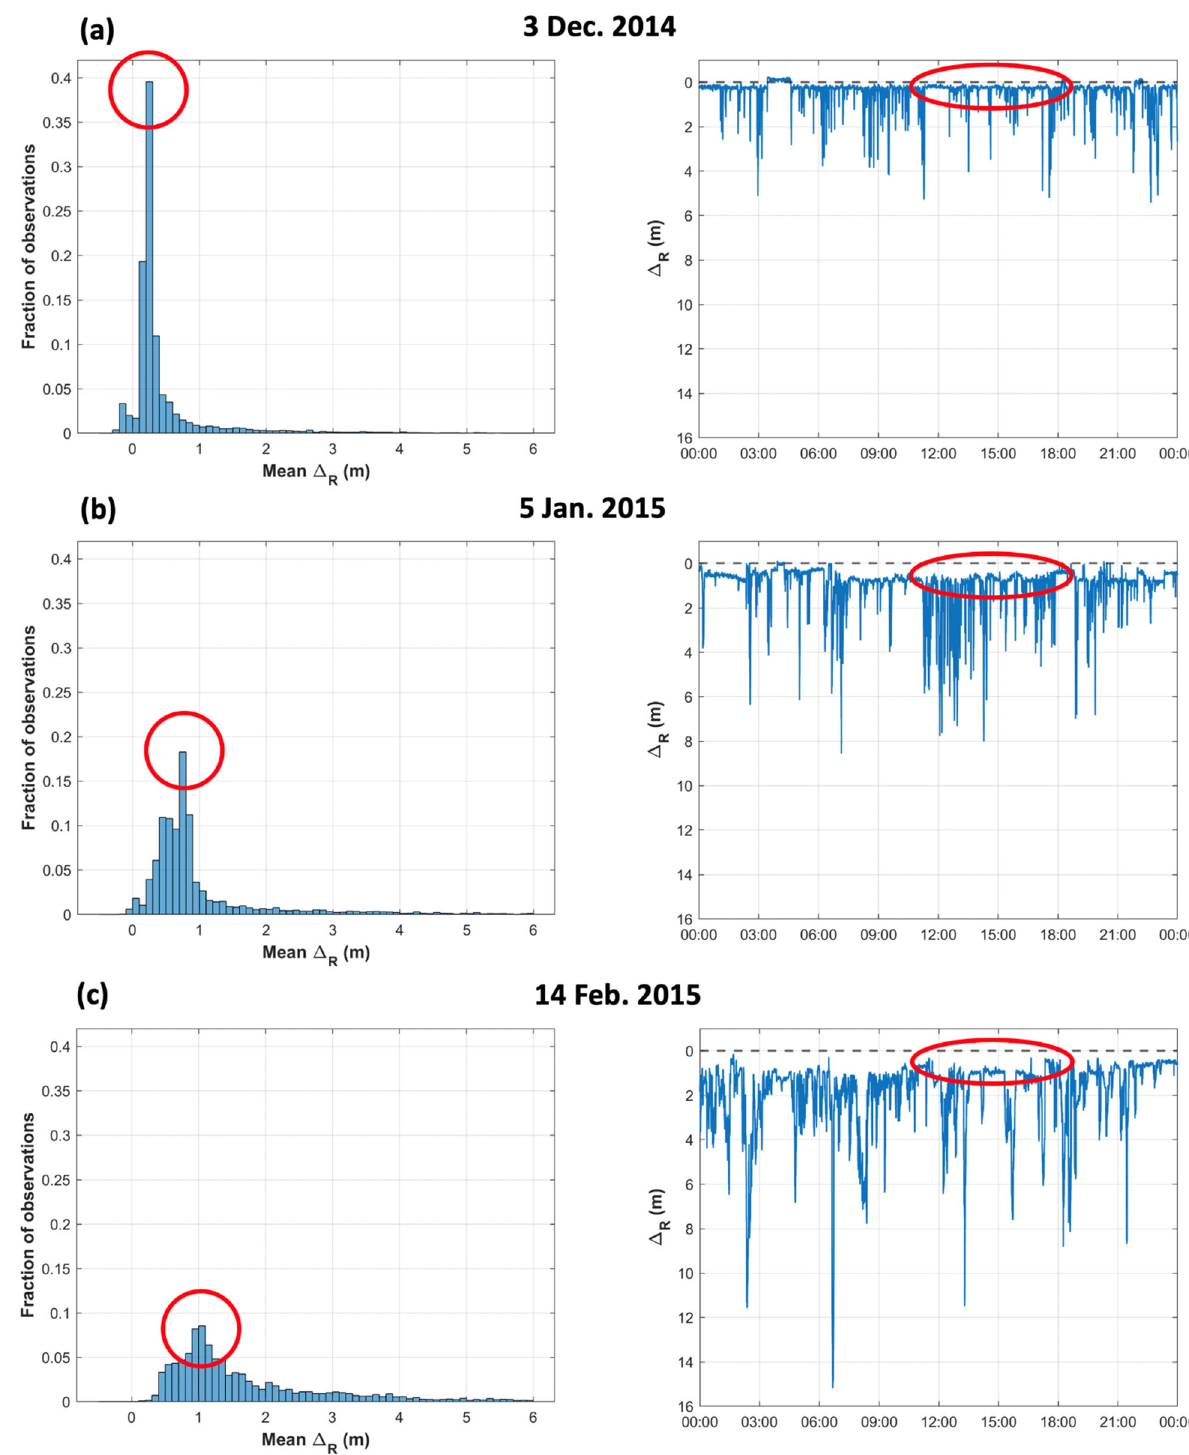
Figure 14. Time series and histograms of ∆ R illustrating changes in level ice thickness. Histograms of ∆ R estimates (10 cm bins) from the AZFP at the CEO site in the NE Chukchi Sea are plotted for 3 December 2014 ( a ), 5 January 2015 ( b ), and 14 February 2015 ( c ), including only pings in which sea ice was present above the CEO mooring (left panels). Corresponding time series of ∆ R are plotted in the right panels. The mode of the ∆ R estimates, circled in red in the histograms, corresponds to the level ice in the ∆ R time series (a representative sample is also circled in red). The dashed black line represents the undisturbed sea level.